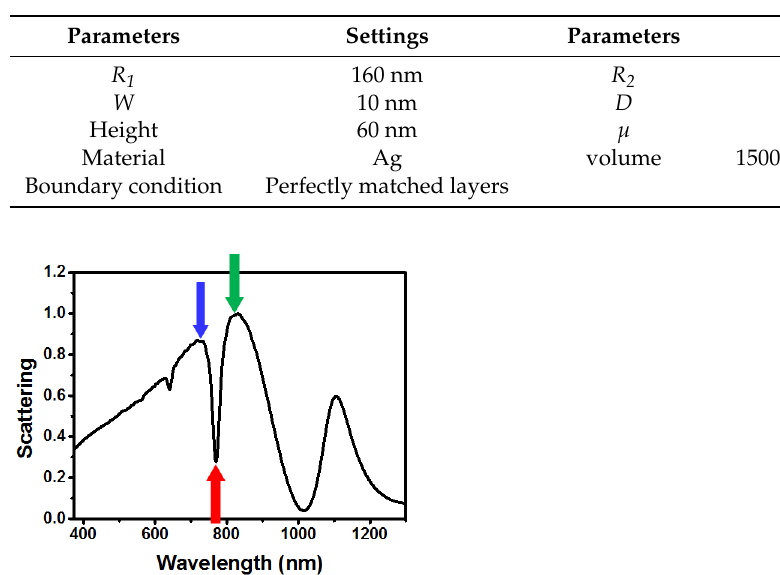
Table 1. Parameter settings.